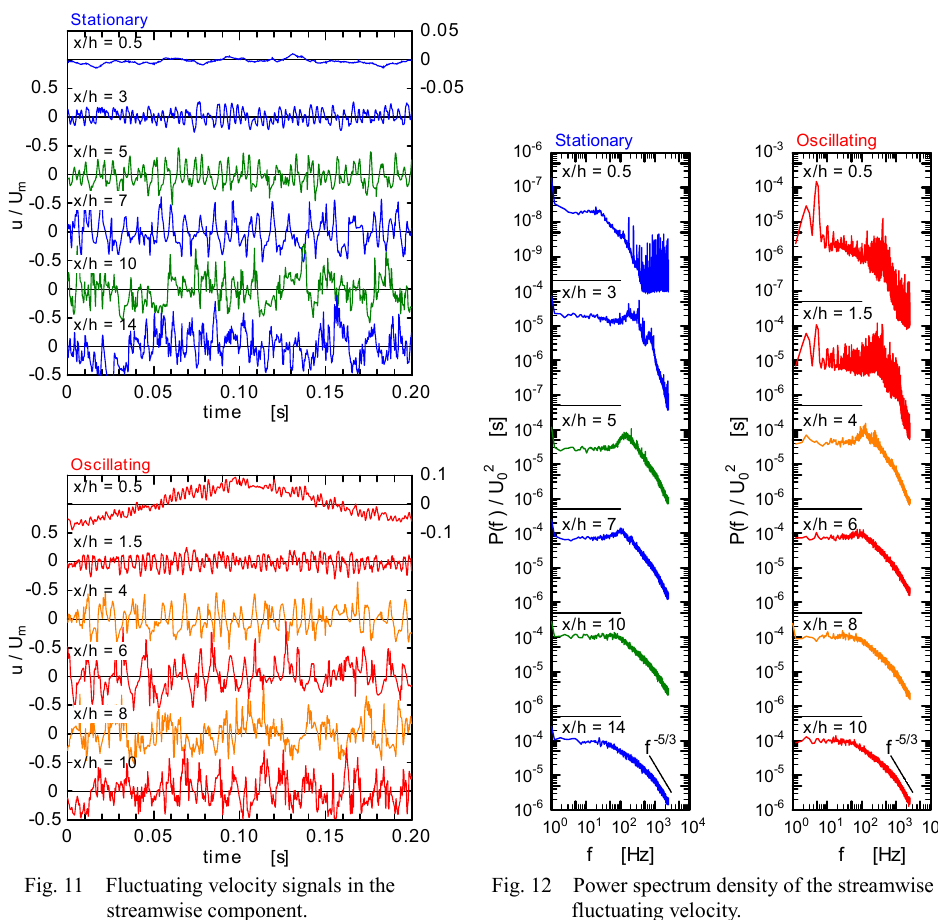
Fig. 11 Fluctuating velocity signals in the Fig. 12 Power spectrum density of the streamwise streamwise component. fluctuating